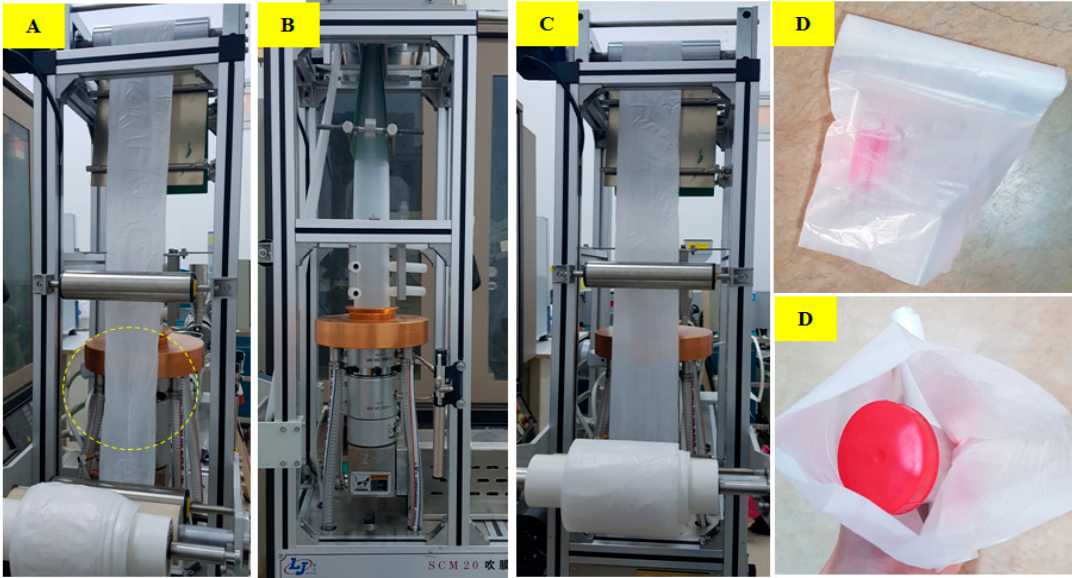
Figure 9. Mater-Bi/PLLA (60/40) blend ( A ), compatibilized Mater-Bi ® /PLLA (60/40) blend during the film-blowing process ( B , C ), and the final product ( D ). Table 6. Main tensile properties of the corresponding blend in the machine direction (MD) and transverse direction (TD) of the blown film, and comparison with film from HDPE and neat Mater- Bi ® .